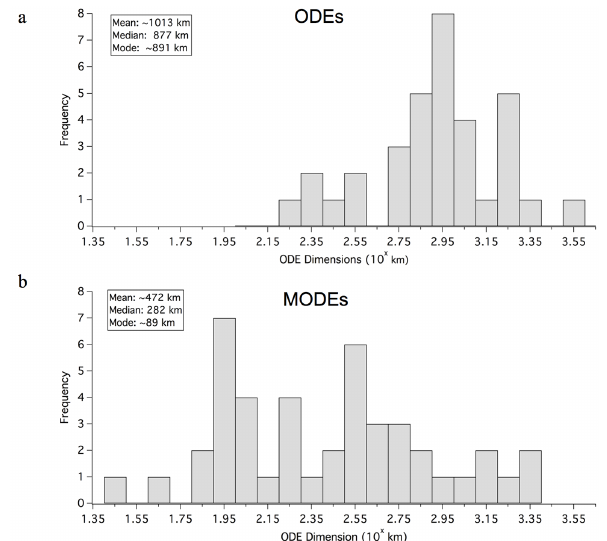
Figure 8. (a) Histogram of ODE dimensions for all ODEs. The me- dian of the distribution is 877km. (b) Histogram of dimensions of MODEs. The median of the distribution is